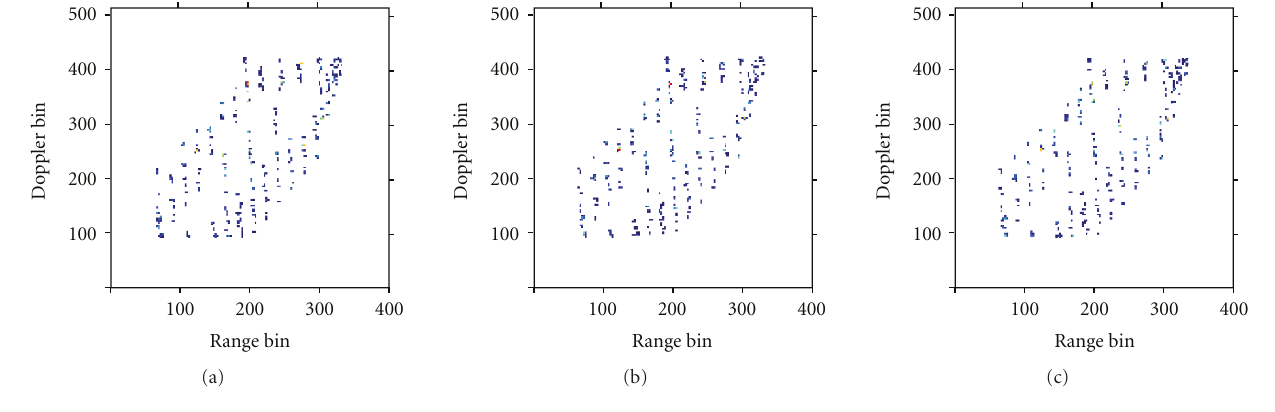
Figure 8: Instantaneous ISAR images based on the IHMPT.